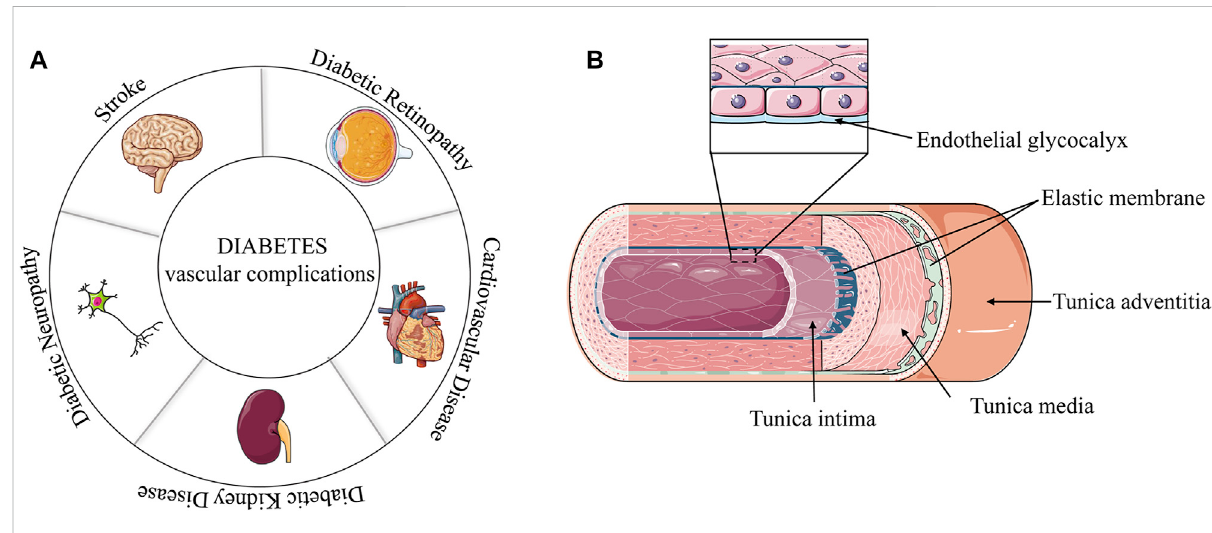
FIGURE 1 (A) Vascular complications of diabetes. (B) Diagram of a vascular